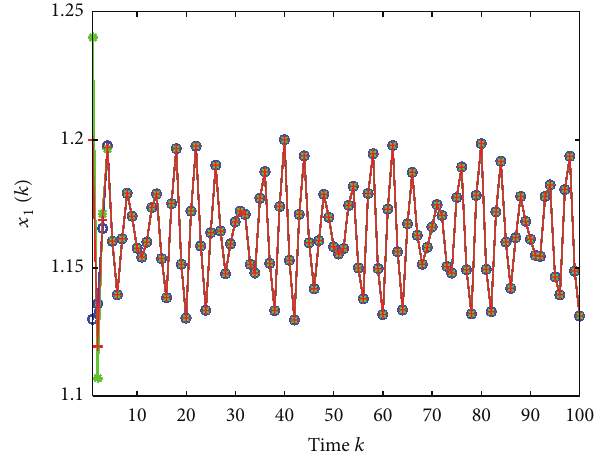
Figure 1: Dynamic behavior of the first component 𝑥 1 (𝑘) of the solution (𝑥 1 (𝑘),𝑥 2 (𝑘),𝑥 3 (𝑘)) to system (74) with the initial conditions (1.13, 1.17, 1.2), (1.24, 0.96, 0.95), and (1.2, 1.08, 1.14) for 𝑘 ∈ [1,100] , respectively.